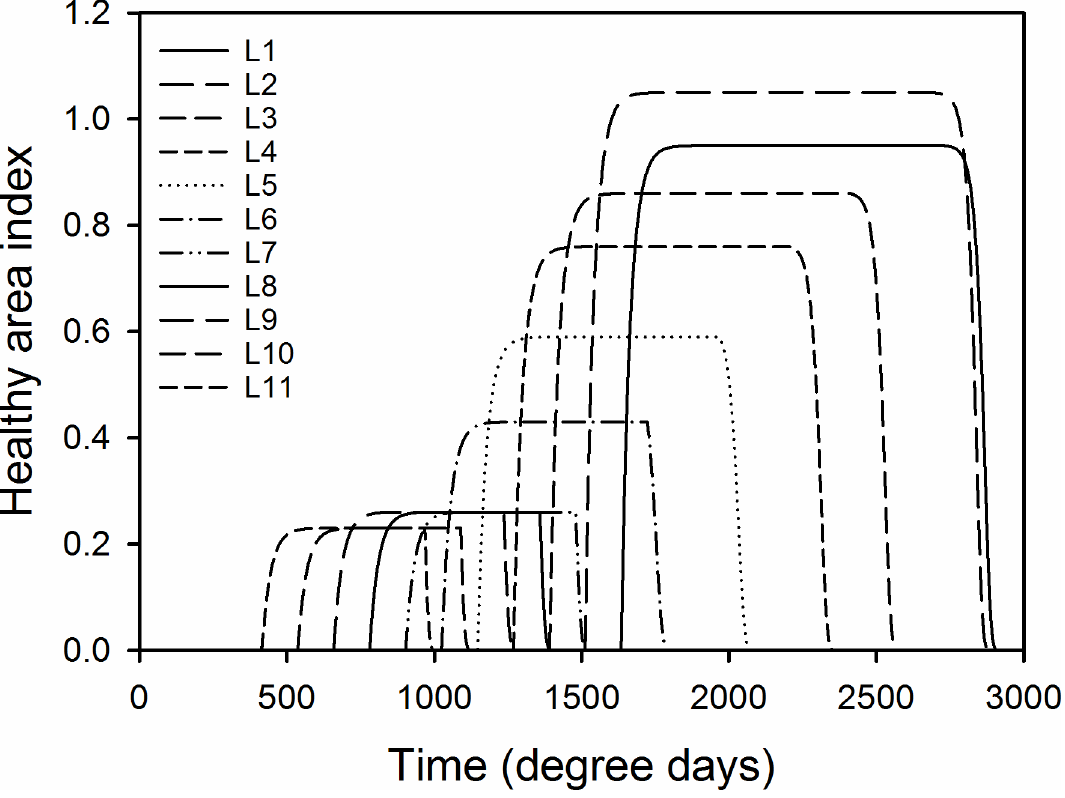
Fig 1. Graphical representation of the 11 leaves in the crop canopy growth model in the absence of disease. Leaf lives overlap and were comprised of a monomolecular growth phase, a lag phase and a logistic senescence